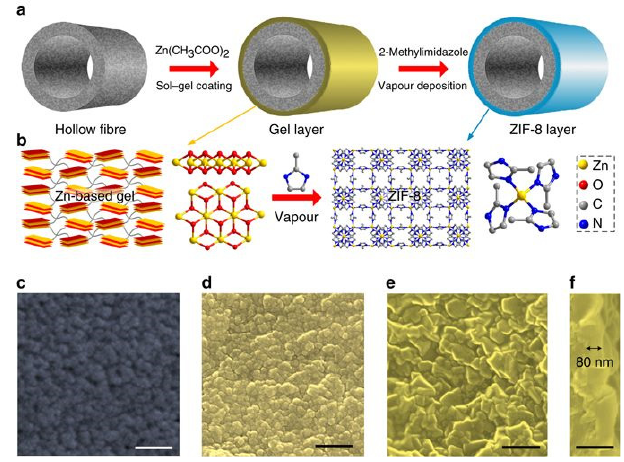
Figure 6. GVD fabrication of an ultrathin ZIF-8 membrane. ( a ) Schematic of the MOF membrane formation process. ( b ) Schematic illustration and chemical structure of Zn-based gel and crystalline structure of ZIF-8. Zn, O, C, and N atoms are depicted in yellow, red, grey, and blue, respectively. H atoms are not presented for clarity. Top view SEM images of ( c ) the PVDF hollow fibre and ( d ) the Zn-based gel layer. SEM images of ( e ) top and ( f ) cross-sectional view of the ZIF-8 membrane prepared with sol concentration of 1 U and coating time of 2 s. The images are coloured for clarity. Scale bar, 200 nm. Reprinted with permission from [72], Copyright (2017) Springer